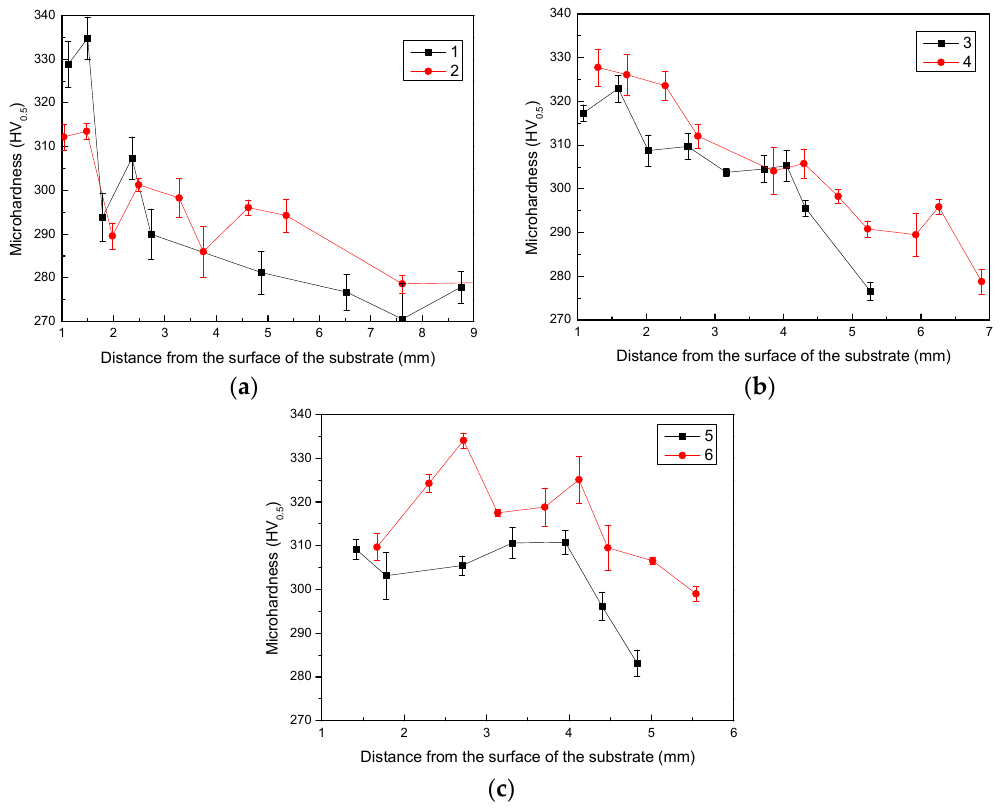
Figure 12. Microhardness (HV) distribution of 6 groups of the single track along the depth direction from the top surface of the substrate: ( a ) Sample 1 and 2; ( b ) Sample 3 and 4; ( c ) Sample 5 and 6.